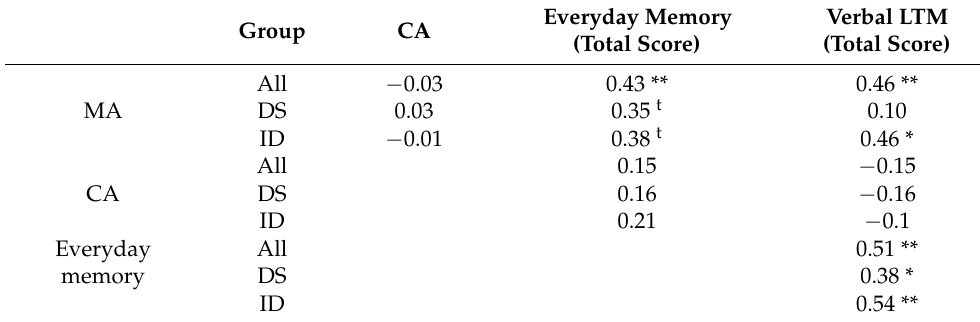
Table 2. Correlations between MA, CA, Everyday Memory, and Verbal Memory.